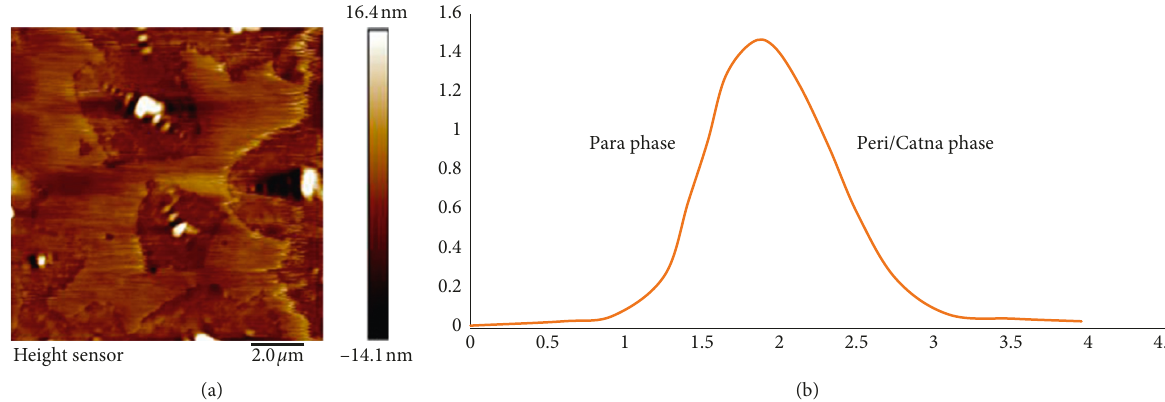
Figure 20: Different phases exhibit different adhesion force in the left image (a). Frequency distribution of adhesion forces (b). The Figure 20(b) is reproduced from Fischer et al. [49] (under the creative commons attribution license/public